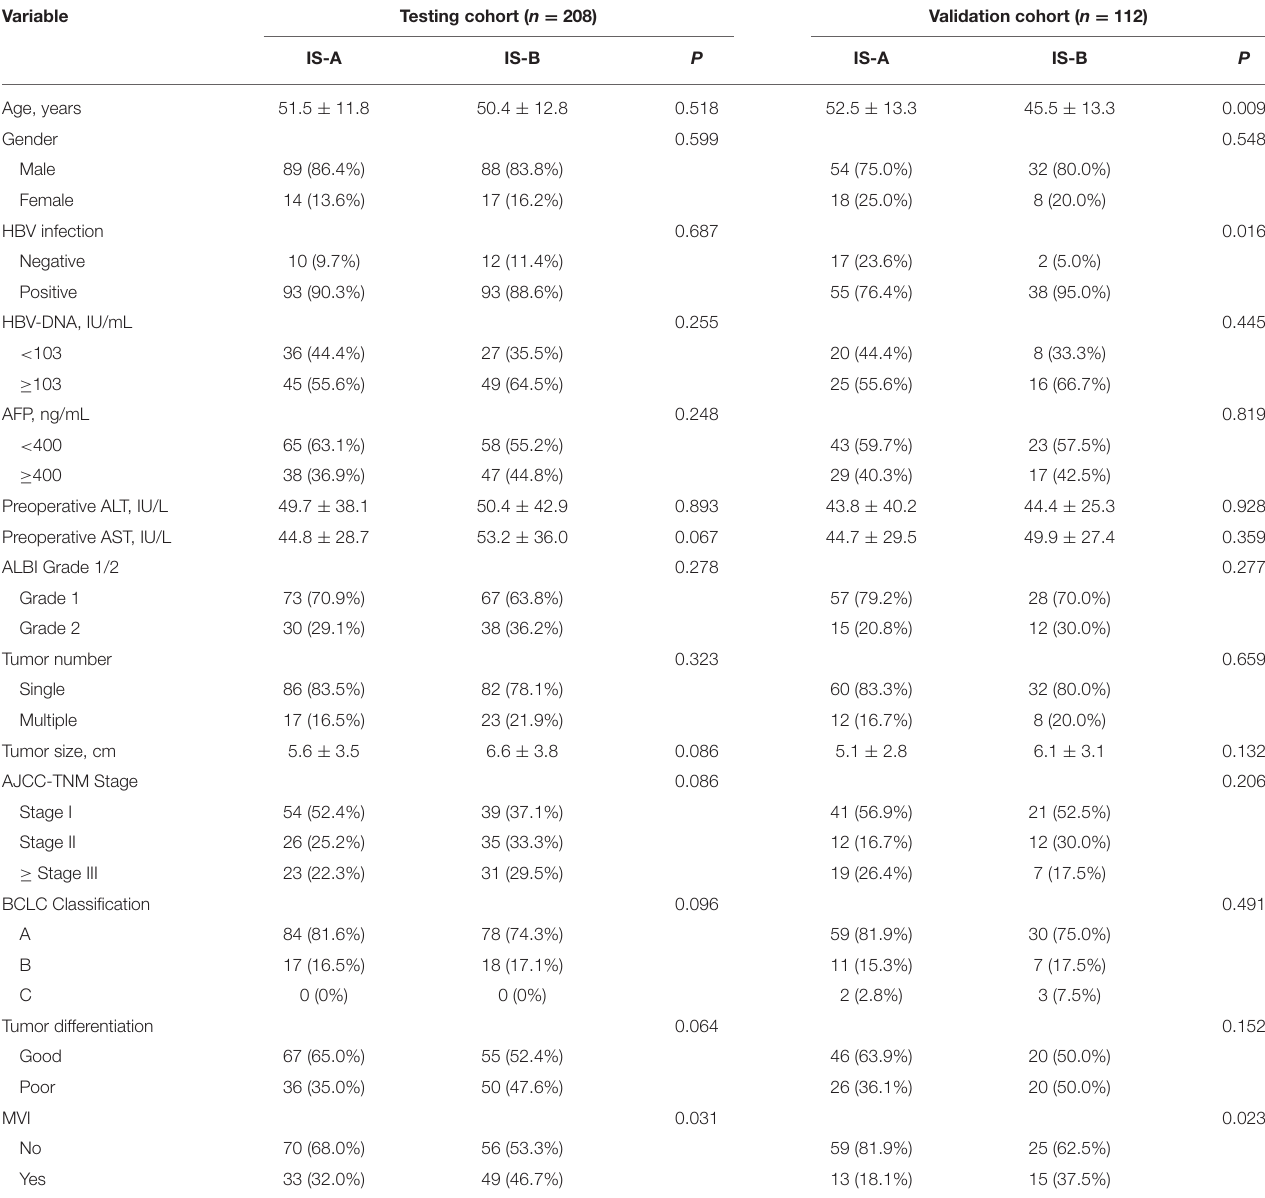
TABLE 1 | Clinicopathological characteristics of patients according to the immunotype (OS) in the testing and validation Cohorts.